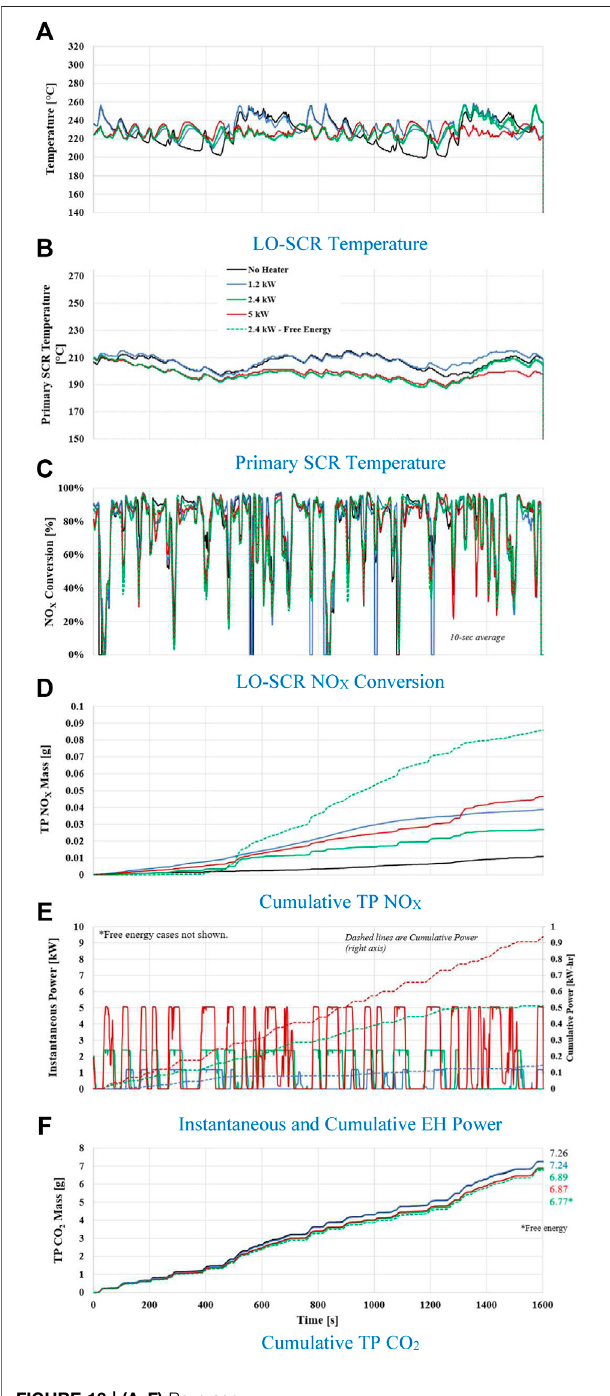
results with a CO 2 reduction of 6% or greater. The 2.4 kW free